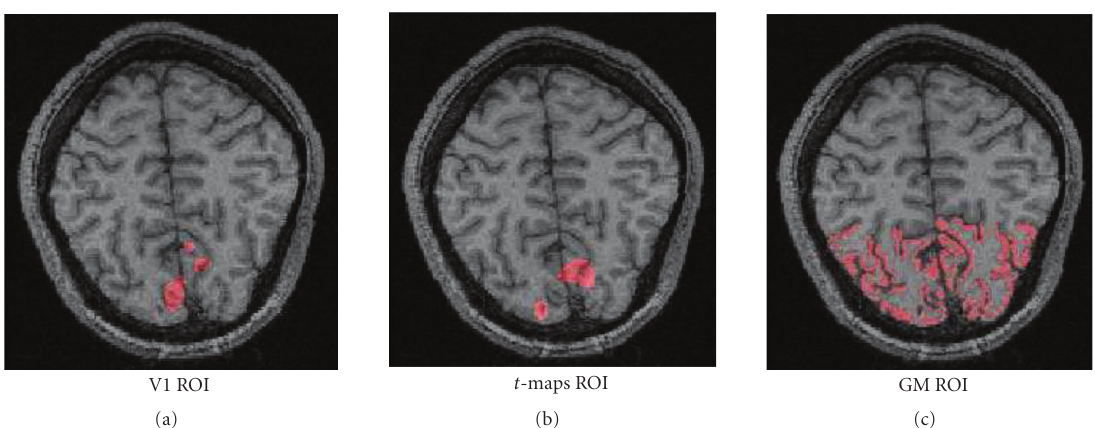
Figure 3: Sample ROIs (shown in red) defined for one subject. The V1 ROI was obtained by retinotopic mapping, the t -map ROI included common voxels from thresholded and resampled FAIR and PET t -maps, and the grey matter (GM) ROI was defined by Bayesian classification of the anatomical